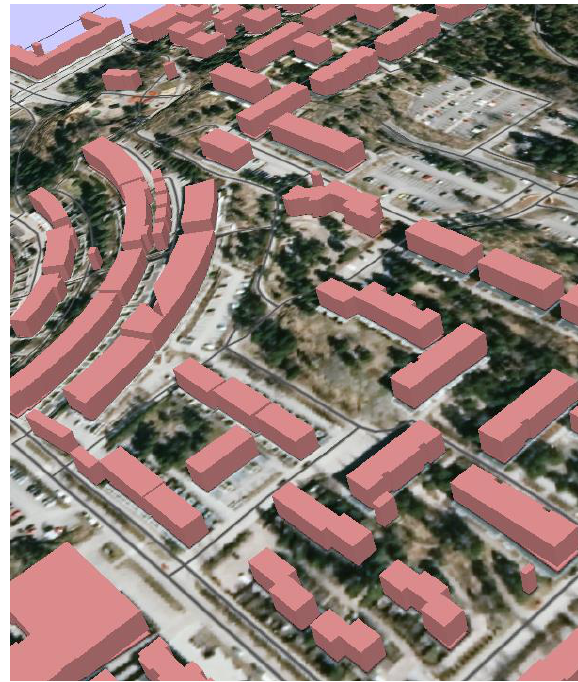
Figure 4: Espoonlahti city area visualized with three.js. The result is viewed with standard web